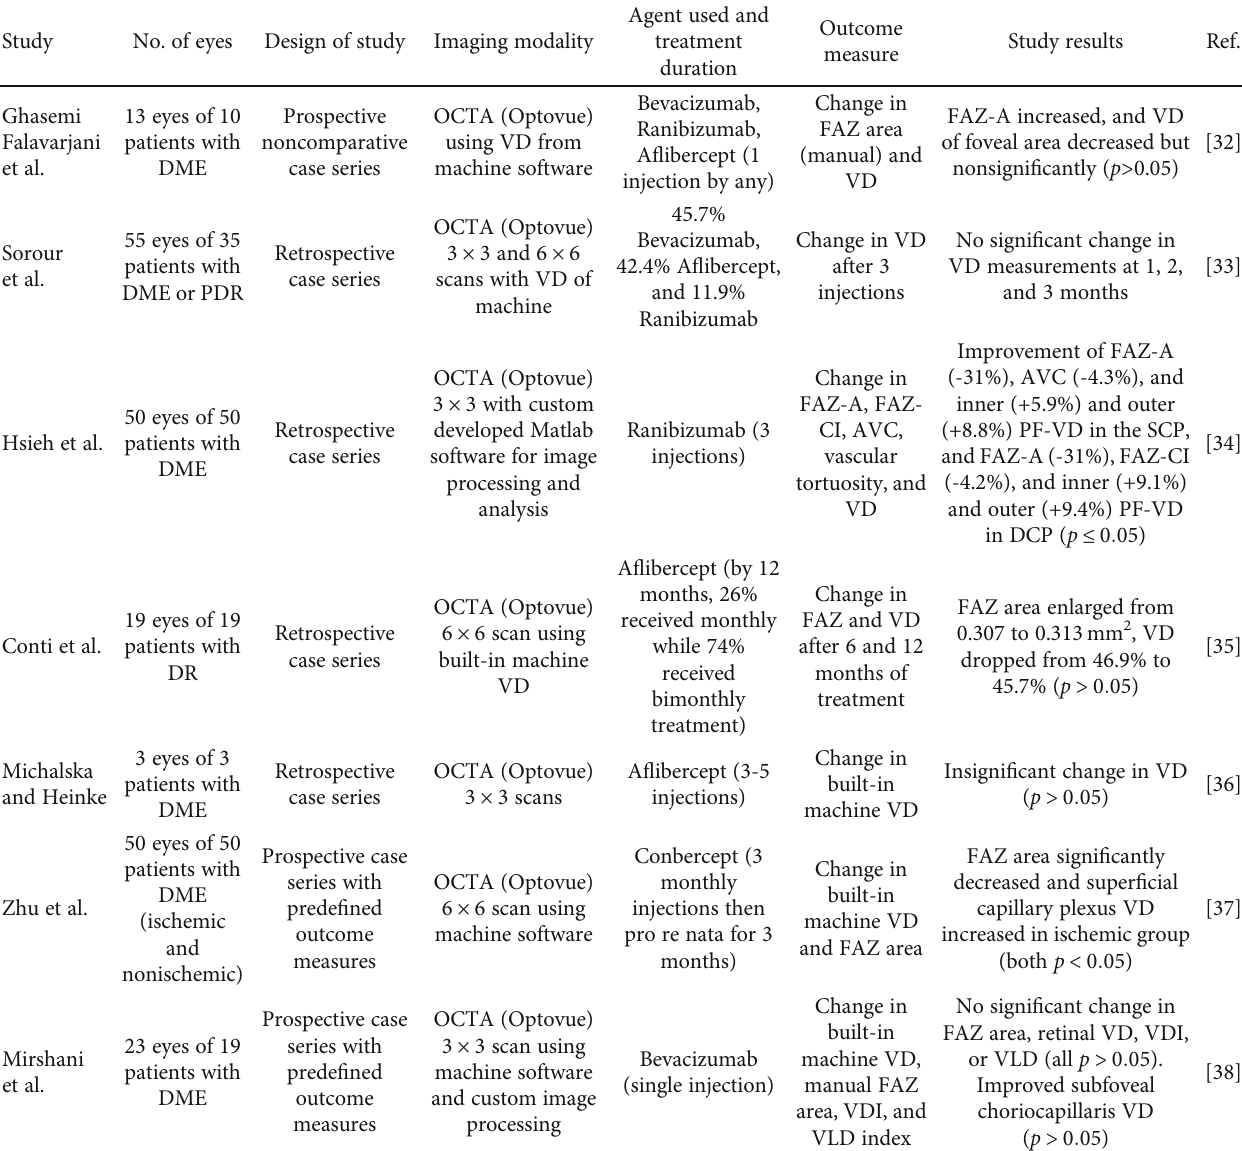
Table 1: Study design, methods, and results of studies that found stable or improved macular perfusion following injections. Study No. of